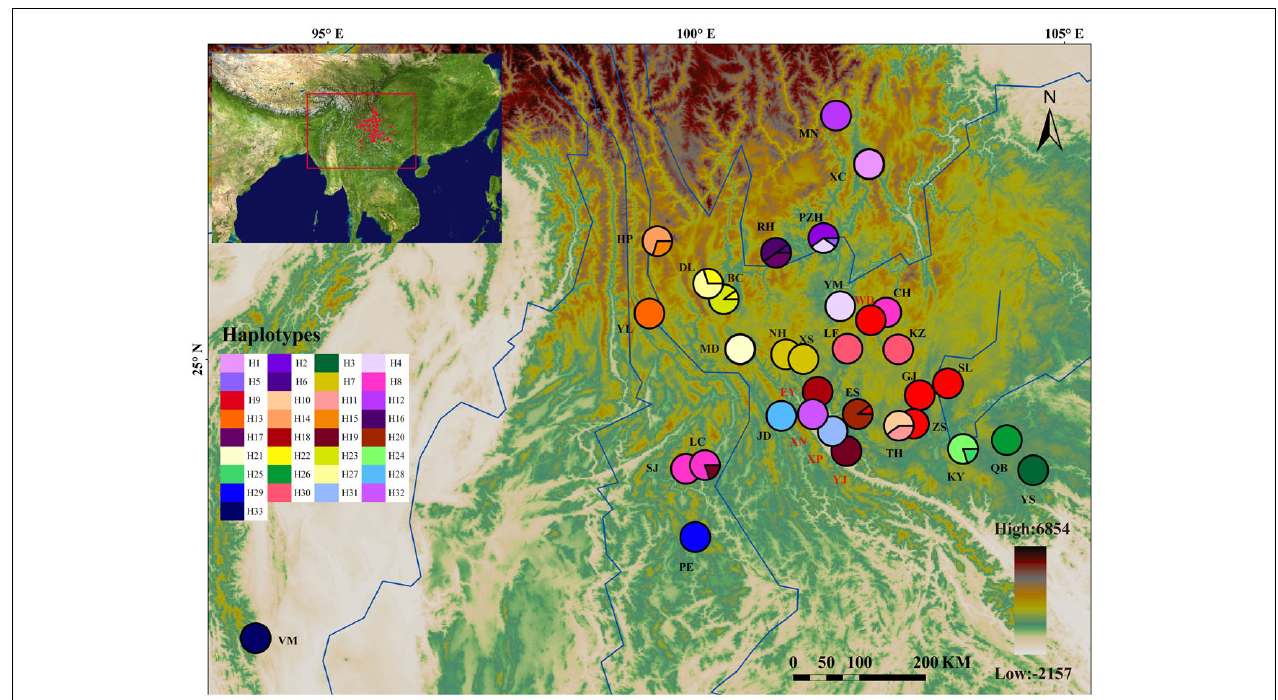
FIGURE 1 | Geographic distribution of 33 cp DNA haplotypes detected in the Quercus franchetii complex. The colored pie charts representing the frequencies of haplotypes at each sampling site. Haplotype colors corresponding to the charts are shown in the left panel. The color scale representing different elevation gradients are shown in the lower-right panel. The population with less than 10 individuals were marked with red population